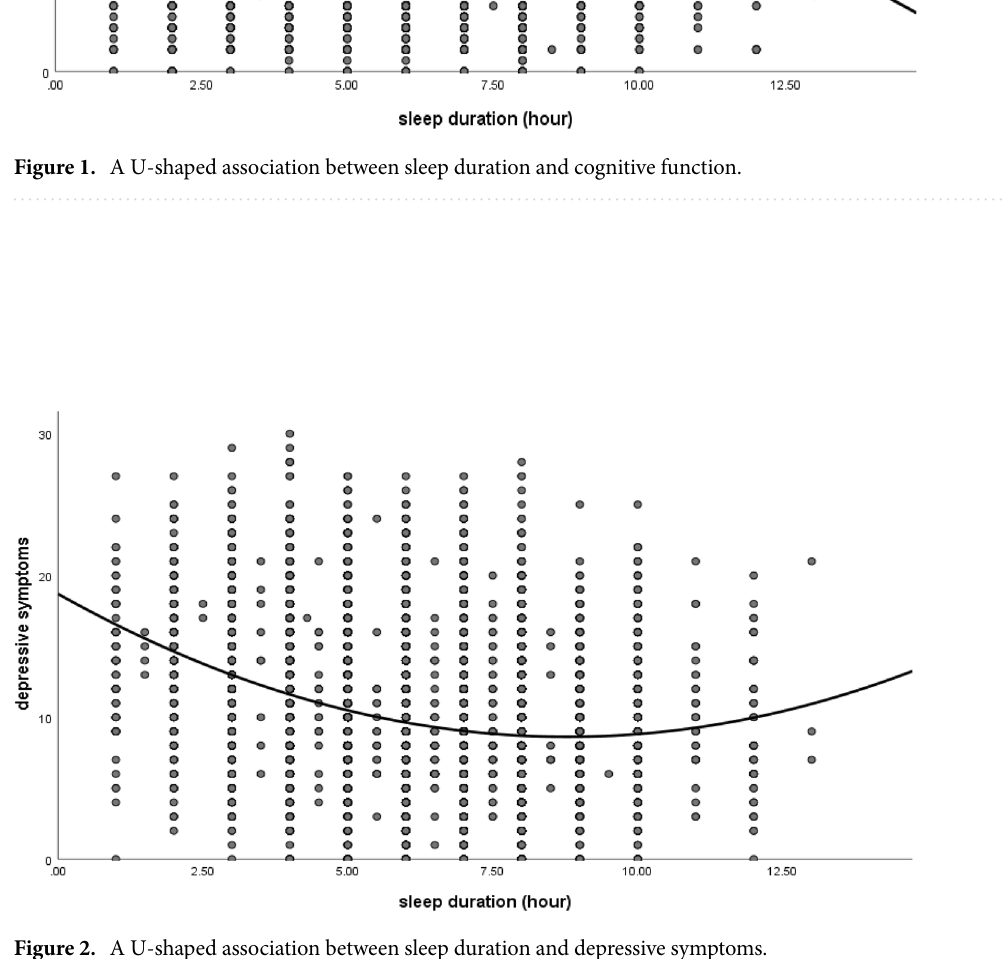
Figure 2. A U-shaped association between sleep duration and depressive